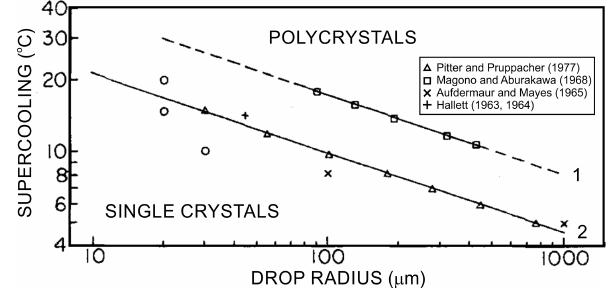
Figure 5. Dependence of the polycrystallinity of frozen droplets on the average droplet size frozen as single crystals and freezing temperature of droplets. (1) Droplets freely suspended in vertical airflow and nucleated by contact with clay particles. (2) Droplets frozen on the surface of large single crystals. Adapted from Pitter and Pruppacher (1973).